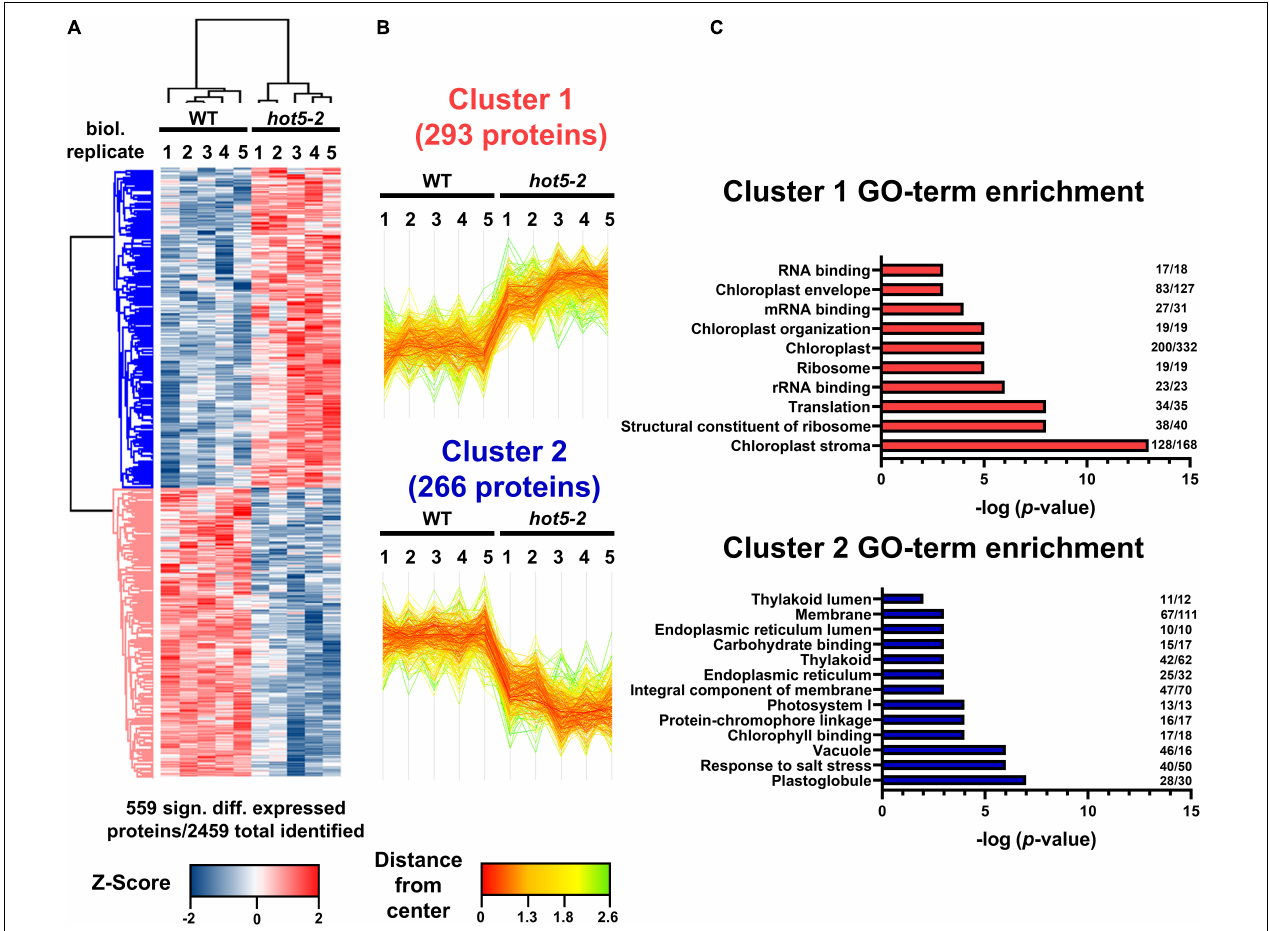
FIGURE 1 | Quantitative proteomic analysis of WT and hot5-2 leaf material. (A) Heatmap of differentially expressed proteins in WT Col 0 and hot5-2 leaves from 4- to 6-week-old soil grown plants. Five biological replicates were used per genotype. LFQ intensities were z -scored prior to Euclidean distance-based hierarchical clustering with Perseus. Five hundred and fifty-nine from a total of 2469 detected proteins are differentially regulated (FDR 5%). Blue and red indicate a lower and higher abundance for each protein in the samples. (B) Specific expression patterns in the leaf proteome dataset. Two clusters with 293 and 266 differentially regulated proteins show up- (cluster 1) or downregulation (cluster 2), respectively. (C) Gene ontology (GO) enrichment of clusters. p -Values of significant GO-terms regarding biological processes, molecular functions, and cellular compartment were –log transformed and displayed in bar graphs. Numbers at the end of each bar represent the number of proteins in that cluster that are associated with the specific GO term. A list of the differentially regulated proteins is provided in Supplementary Data Set 1